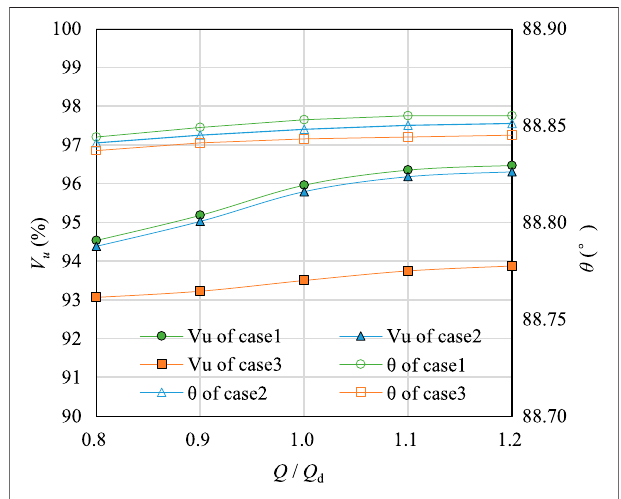
FIGURE 11 | Axial velocity distribution uniformity V u and the velocity- weighted average angle θ on the outlet of the inlet passage for each case.